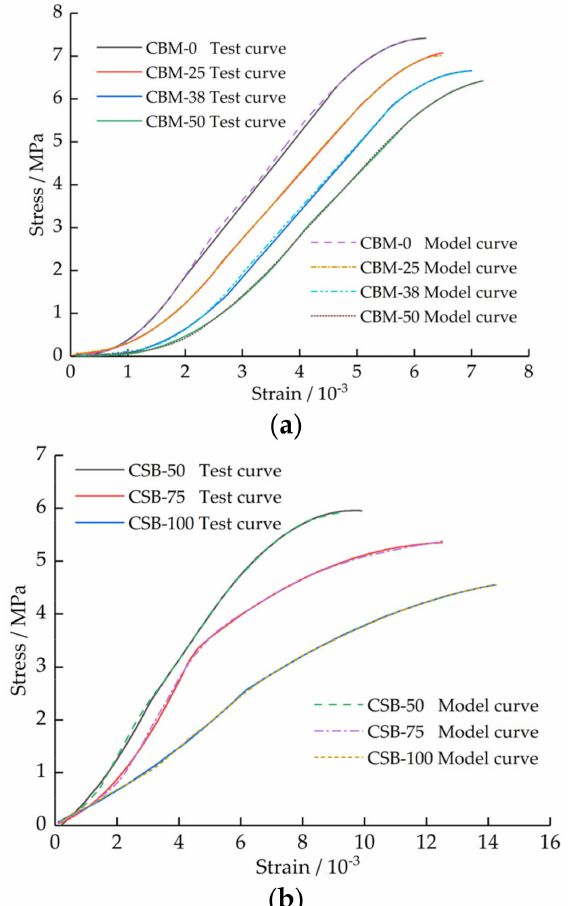
Figure 15. Comparison of test curve and model curve. ( a ) CBM group. ( b ) CSB